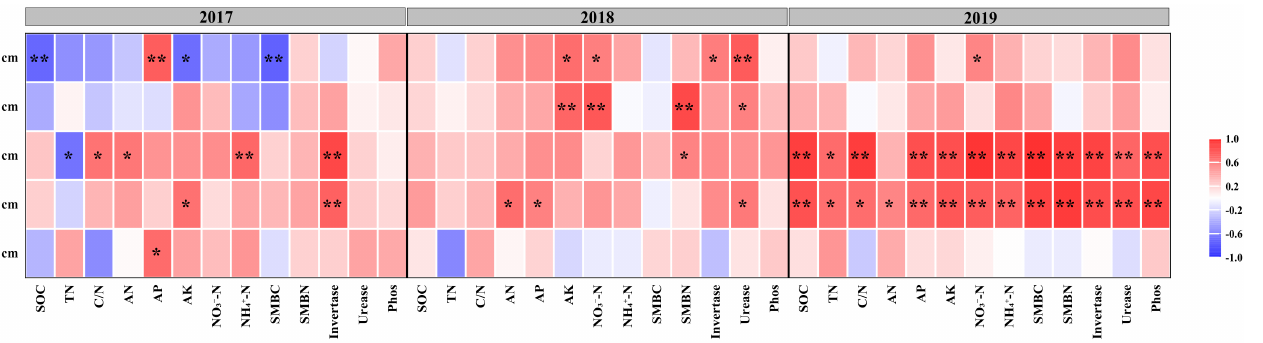
Figure 8. Plot of correlation coefficients between soil nutrient content and maize yield. * represents p < 0.05; ** represents p <